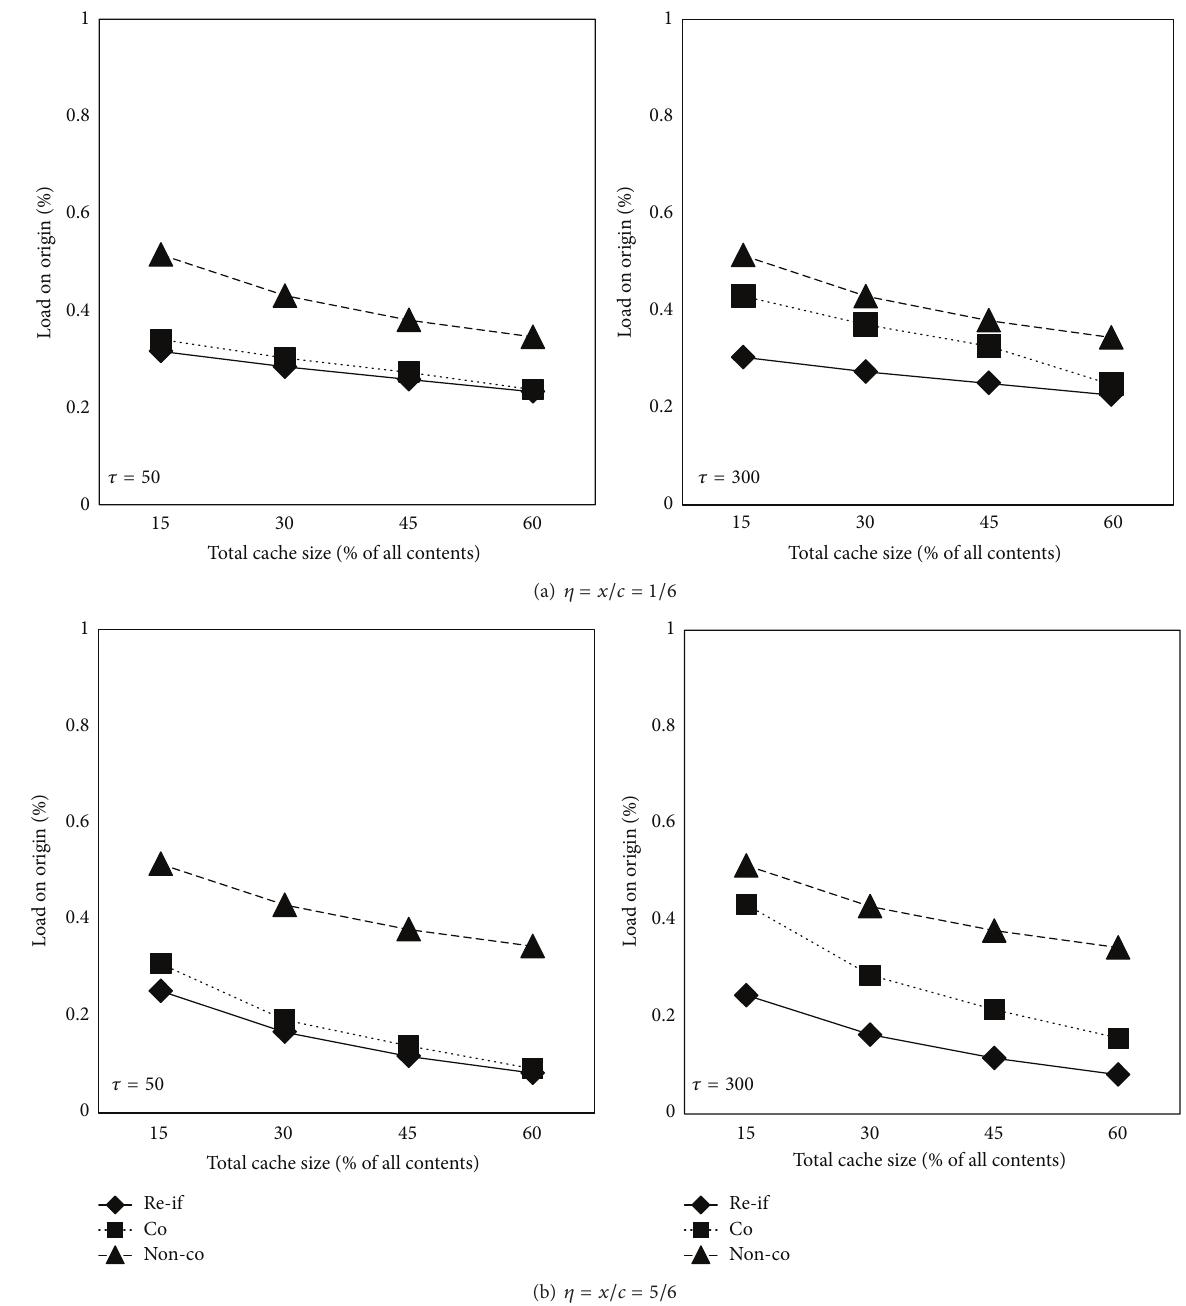
Figure 6: Load on origin versus cache